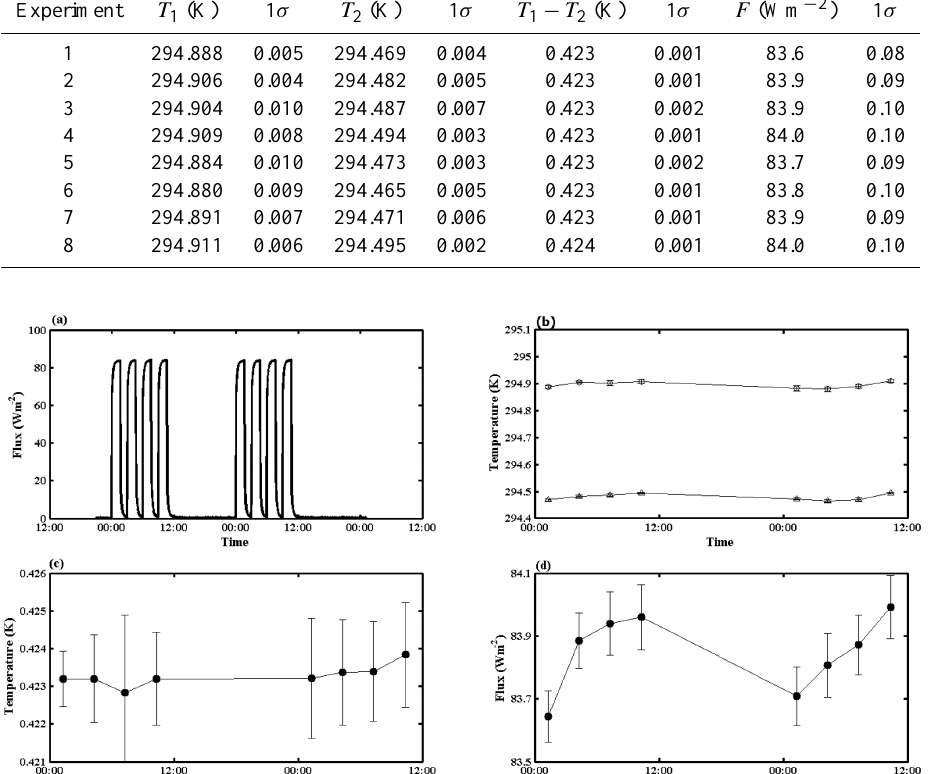
Figure 3. The instrument was tested in a temperature-controlled clean room. (a) Eight cycles of an on/off radiation source. (b) Temperatures of T1 and T2 measured around the peak of each cycle. (c) The temperature difference T1–T2. (d) Flux computed from temperatures T1 and